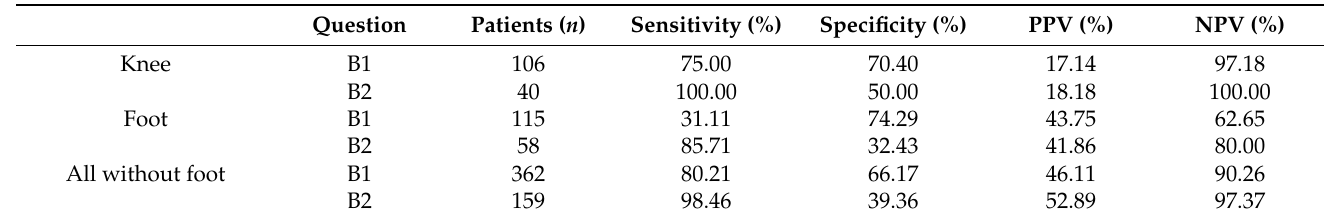
The VAS values throughout the study population and for the fractured patients are shown in Figure 2. A normal distribution seemed to be apparent, with the highest number of patients having a VAS value of five among all patients in the ED. Most patients with fractures had a VAS score of seven.